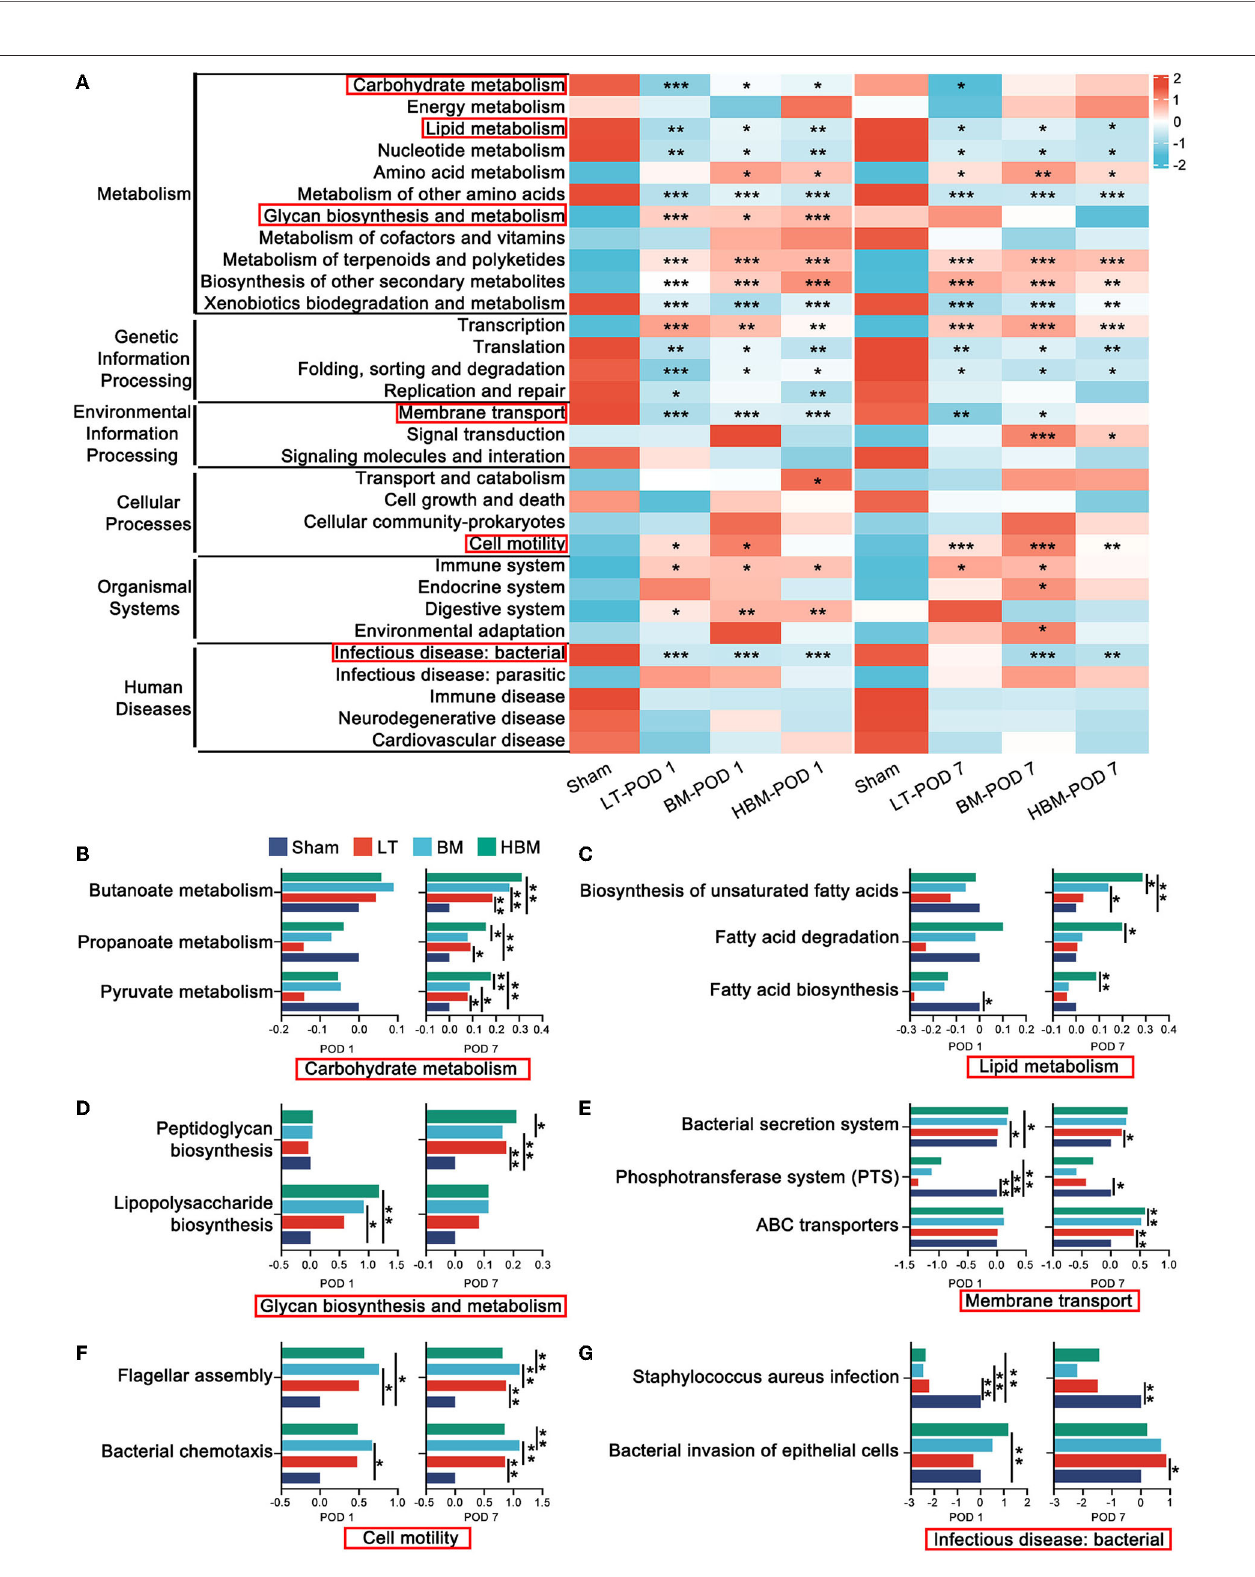
FIGURE 7 | PICRUSt functional prediction of changes in the intestinal microbiota. (A) Six main pathways at level 1 and 31 main pathways at level 2. Among them, carbohydrate metabolism, lipid metabolism, glycan biosynthesis and metabolism, membrane transport, cell motility, and bacterial infection disease play an important role in the repair process involved in the steatotic transplanted liver (the important secondary pathways are in the red box). (B) The expression levels of genes related